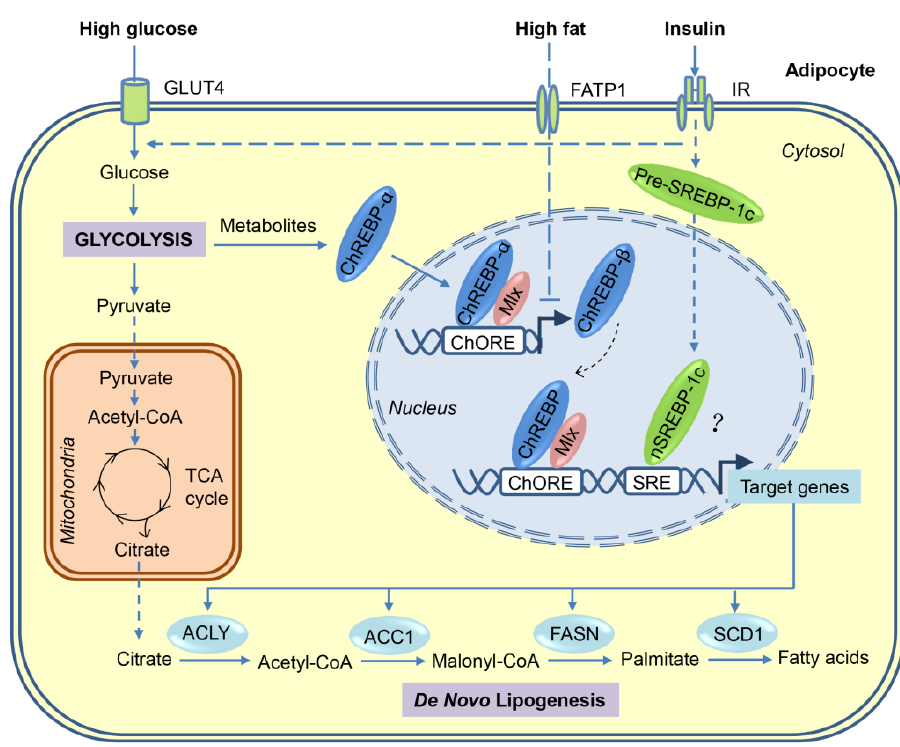
Figure 1. Transcriptional activation of de novo lipogenesis in adipocytes in response to high-sugar or high-fat diets. After the consumption of carbohydrates, a portion of the circulating glucose is taken by adipocytes through insulin-stimulated GLUT4, and then through glycolysis in the cytosol, glucose is converted to pyruvate, which is transported into mitochondria for further oxidation in the tricarboxylic acid (TCA) cycle. Citrate, an intermediate of the TCA cycle, is exported into cytosol and used as a substrate for de novo lipogenesis. Regulation of lipogenesis is mainly at the transcriptional level and carbohydrate response element-binding protein (ChREBP) plays a major role in adipocyte lipogenesis. Glucose metabolites generated during glycolysis activate ChREBP- α , which, together with Max-like protein X (MLX), binds to the carbohydrate response elements (ChoRE) in the promoters of target genes, including those encoding ATP-citrate lyase (ACLY), acetyl-CoA carboxylases 1 (ACC1), fatty acid synthase (FASN), stearoyl-CoA desaturase-1 (SCD1), and ChREBP- β . The induced ChREBP- β in turn further activates its target gene expression, which ultimately promotes the synthesis of fatty acids. Another lipogenic transcription factor sterol regulatory element-binding protein-1 (SREBP-1), induced by insulin at multiple levels, may play a minor role in adipocyte lipogenesis. Compared with carbohydrates, fat consumption inhibits de novo lipogenesis in adipocyte mainly through blocking the activation of ChREBP- β . FATP—fatty acid transport protein-1; IR—insulin